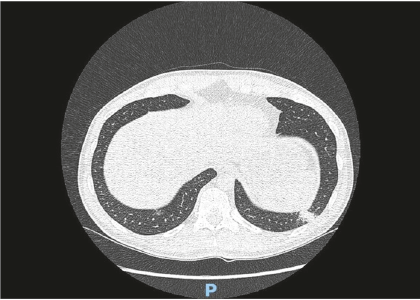
Figure 5: CT of chest showing lower left lobe nodule (Case